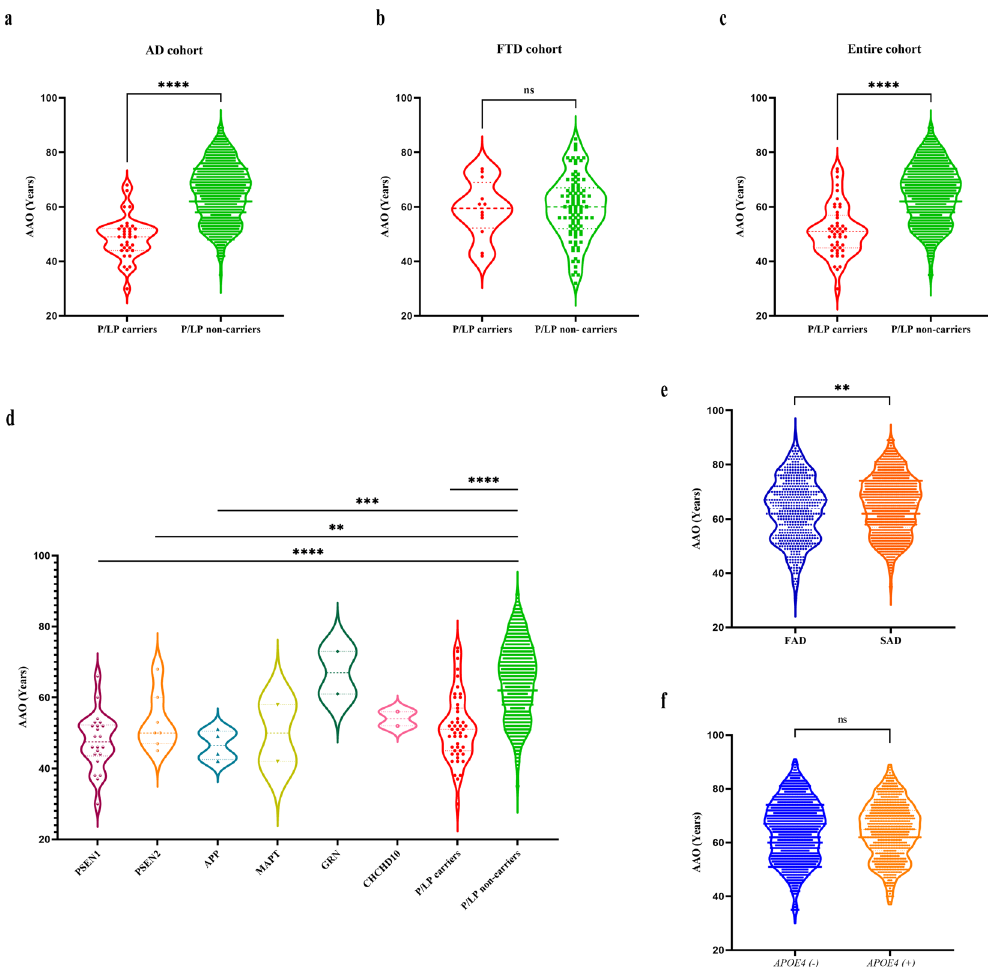
impairment disease-associated genes. a AD cohort. b FTD cohort. c Entire cohort. The dashed red line refers to the mean AAO of patients with P/LP variants in the corresponding cohorts, whereas the dashed line refers to the mean AAO of patients without P/LP variants in known cognitive impairment disease-associated genes in the corresponding cohort. d Spectrum of AAO in patients with P/LP variants of each cognitive impairment disease-associated gene (only genes carried by two or more patients were included), in patients with and without P/LP variants of known cognitive impairment disease-associated genes. e Spectrum of AAO in FAD and SAD patients. f Spectrum of AAO in patients with and without APOE4 . * p < 0.05, ** p < 0.01, *** p < 0.001, **** p < 0.0001, ns no signi fi cance. AAO age at onset, AD Alzheimer ’ s disease,